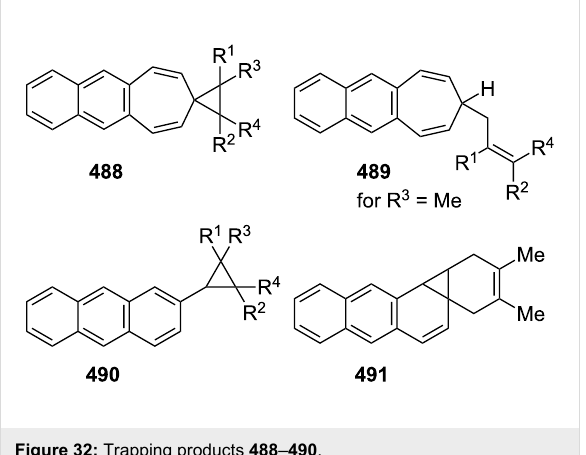
Figure 32: Trapping products 488 – 490